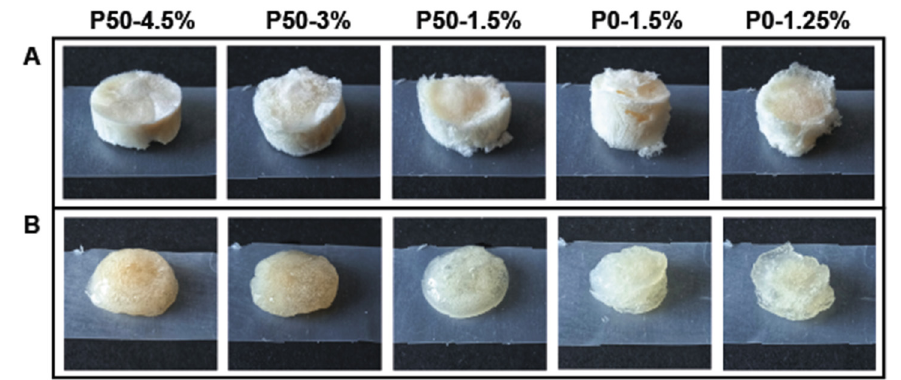
Figure 4. Image of pectin-based materials: ( A ) pectin freeze-dried sponges; ( B ) completely swollen hydrogels.